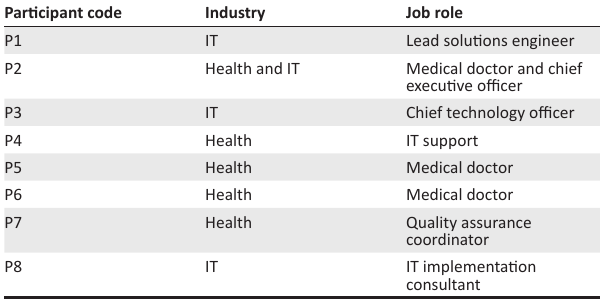
TABLE 1: Description of the study